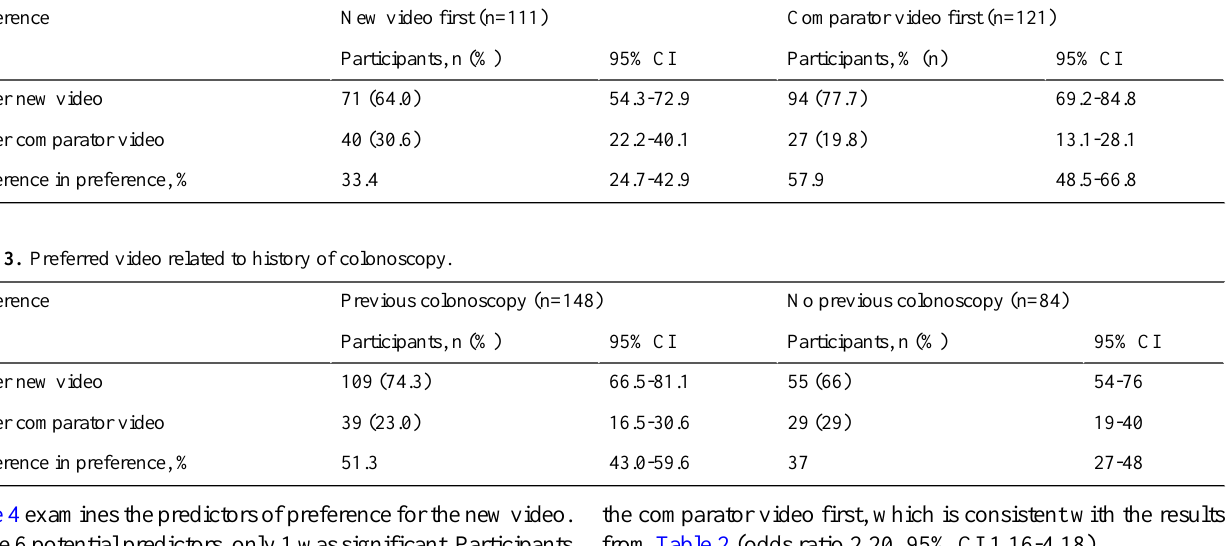
Table 4 examines the predictors of preference for the new